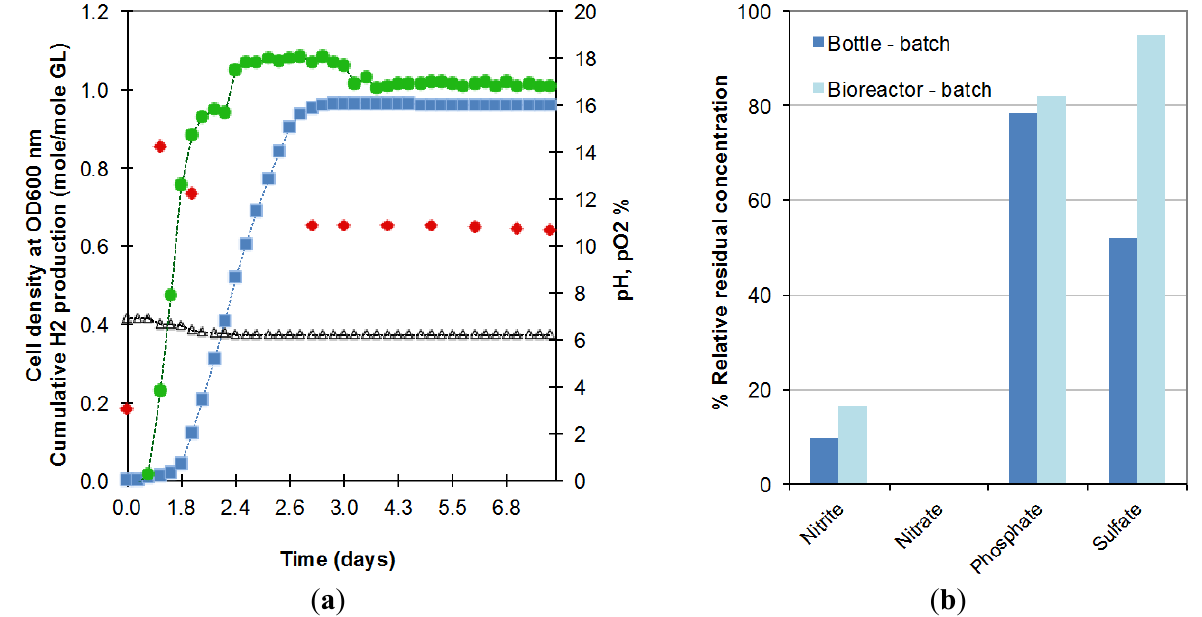
Figure 2. ( a ) Evolution in the batch bioreactor of cell density (♦), cumulative biohydrogen production (■), pH (∆), pO 2 (●) and; ( b ) anion consumption, during the fermentation of 18.5 g/L crude glycerol in bottles (Bottle-batch) and bioreactor (Bioreactor-batch) (2 replicates). The faster production rate obtained in the bioreactor might be attributed to the better